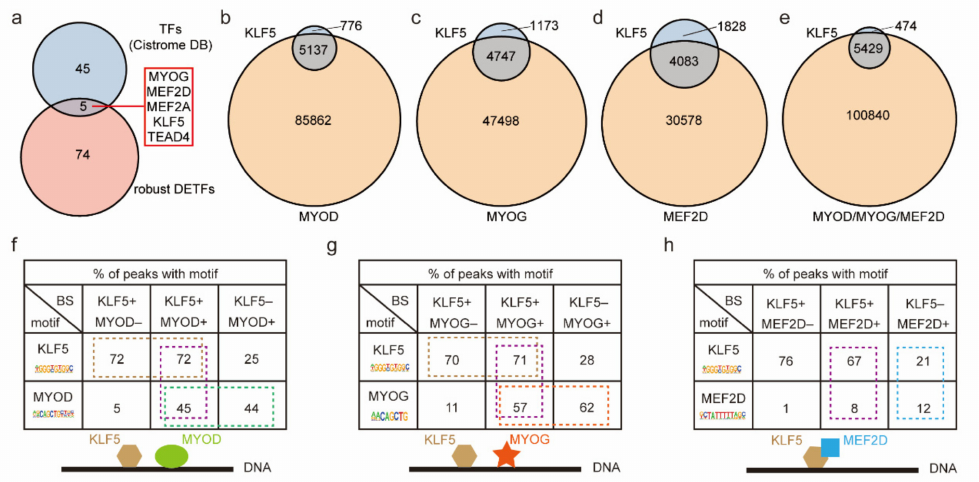
Figure 7. Screening the cooperative binding of robust DETFs. ( a ) The overlap of robust DETFs and TFs of C2C12 cells from the Cistrome DB. The KLF5 peaks overlap with the MYOD ( b ), MYOG ( c ), and MEF2D ( d ) peaks. ( e ) MYOD, MYOG, and MEF2D peaks were merged and intersected with KLF5 peaks. Because of the processing of merged peaks, the number of KLF5 peaks fluctuates slightly within each group. ( f ) The proportion of peaks harboring KLF5 or MYOD motifs among the overlapping and nonoverlapping peaks of KLF5 and MYOD. ( g ) The proportion of peaks harboring KLF5 or MYOG motifs among the overlapping and nonoverlapping peaks of KLF5 and MYOG. ( h ) The proportion of peaks harboring KLF5 or MEF2D motifs among the overlapping and nonoverlapping peaks of KLF5 and